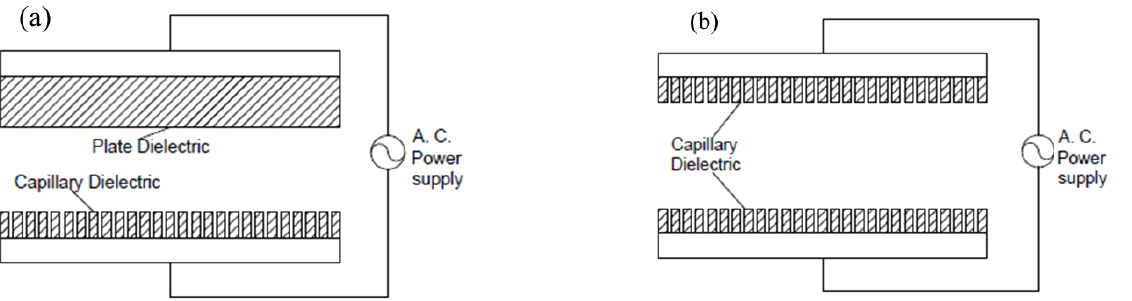
Figure 2. Schematic of capillary plasma electrode configuration: ( a ) single capillary dielectric layer; ( b ) double capillary dielectric layer.